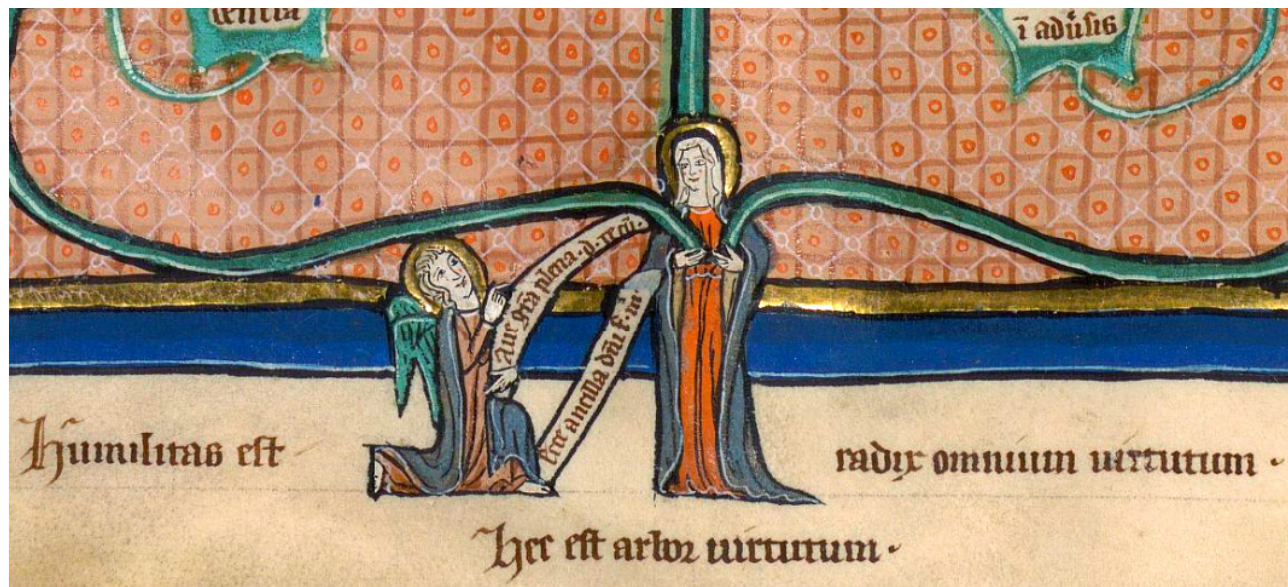
Figure 7. Tree of Virtues, Speculum theologiae, 13th century, Paris, Bibliothèque nationale de France, MS. fr. 9220, fo. 5v (detail).